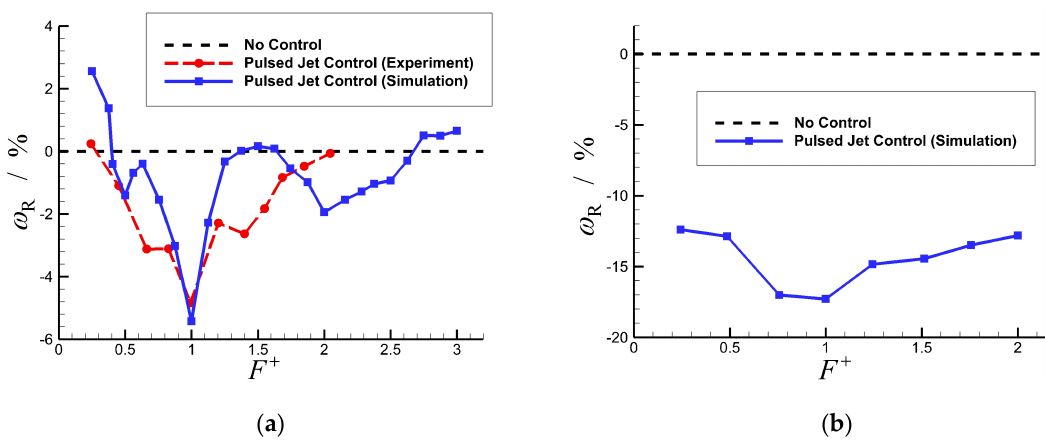
ω Figure 2. Relative total pressure loss coefficient ( R ) of the curved diffuser versus reduced pulsed Figure 2. Relative total pressure loss coefficient ( ω R ) of the curved diffuser versus reduced pulsed jet + frequency ( F + ): ( a ) α = 9 ◦ , C µ = 0.45%; ( b ) α = 12 ◦ , C µ = jet frequency ( F ): ( a )